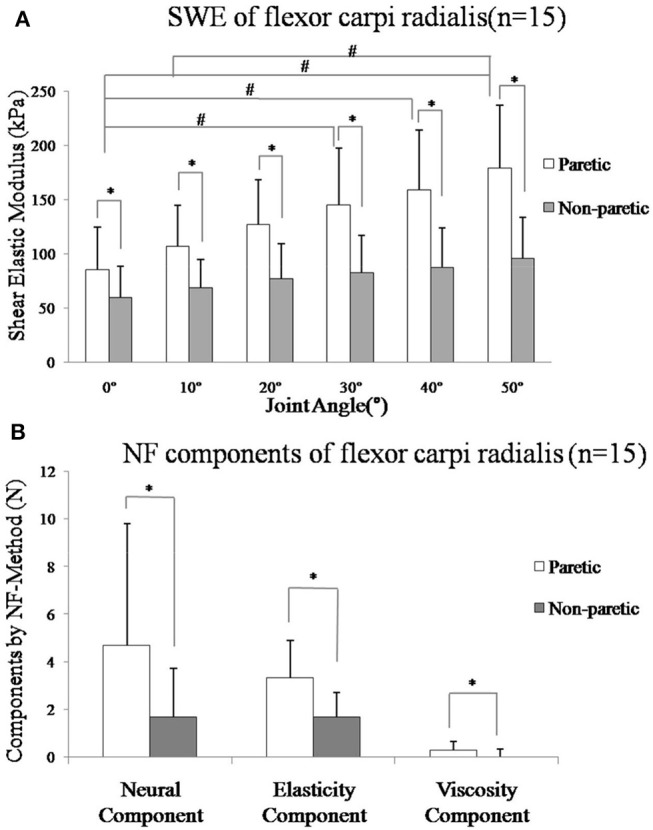
(A) Mean value of shear elastic modulus and standard deviation of the paretic (p: white bars) and non-paretic (n: gray bars) flexor carpi radialis muscle from all subjects in different angle. All subjects (n = 15) SME was greater in the paretic muscle in each angle (p < 0.001). A significant increase was found in paretic side from 0° to 50° (p < 0.001, post-hoc tests on the difference angle between 0° and 30°, p = 0.016, 0° and 40°, p = 0.001, 0° and 50°, p < 0.001, 10° and 50°, p = 0.001), but no significant in non-paretic side (p = 0.05). (B) Mean value of components by NeuroFlexor method and standard deviation of the paretic (p: white bars) and non-paretic (n: gray bars) forearm flexor muscle from all subjects. The mean value of NC (Neural Component), EC (Elasticity Component), and VC (viscosity component) of all subjects (n = 15) was greater in the paretic side (p < 0.05). *Represents statistically significant between the groups, #Represents statistically significant with different angles within the group.